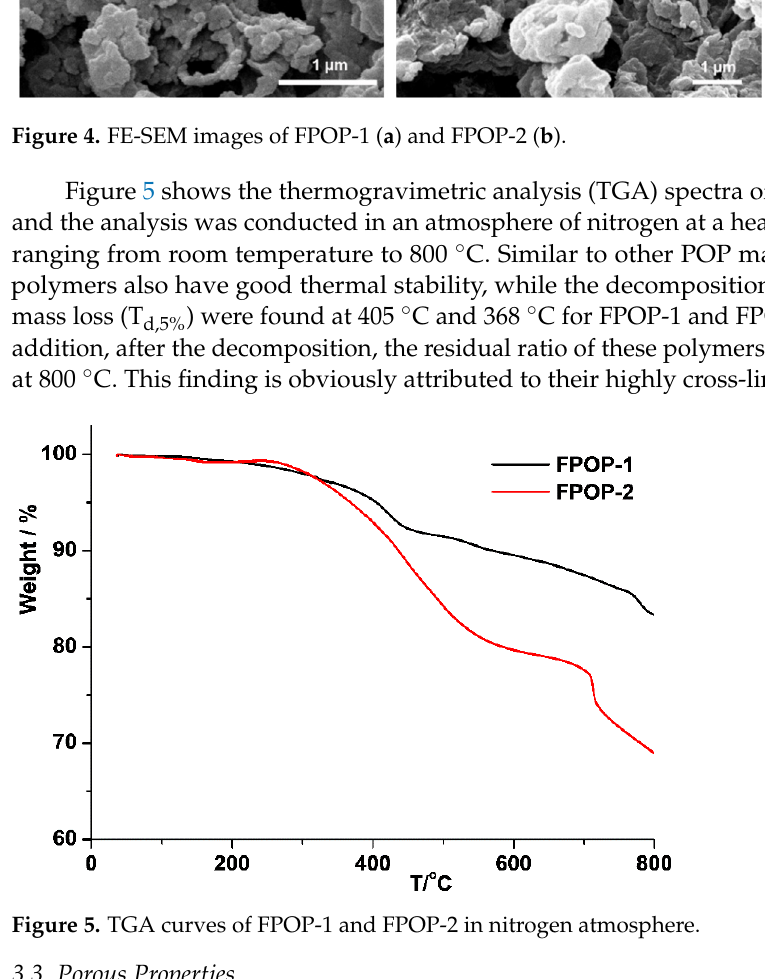
Figure 4. FE-SEM images of FPOP-1 ( a ) and FPOP-2 ( b ).